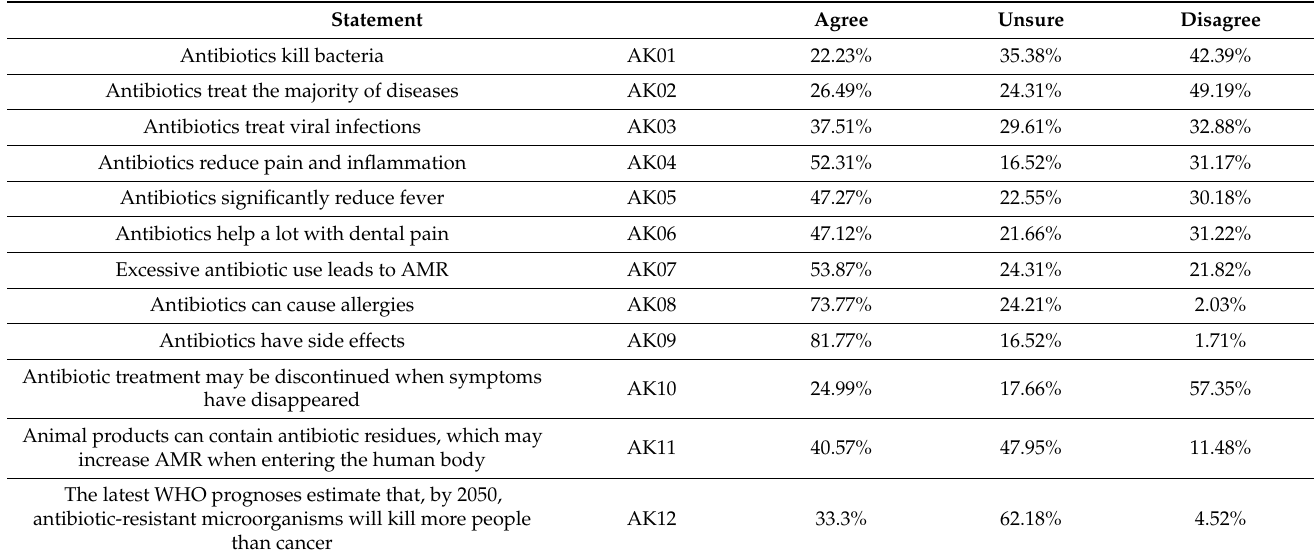
Table 2. Respondents’ knowledge related to antibiotics efficacy, mode of action and antibiotic